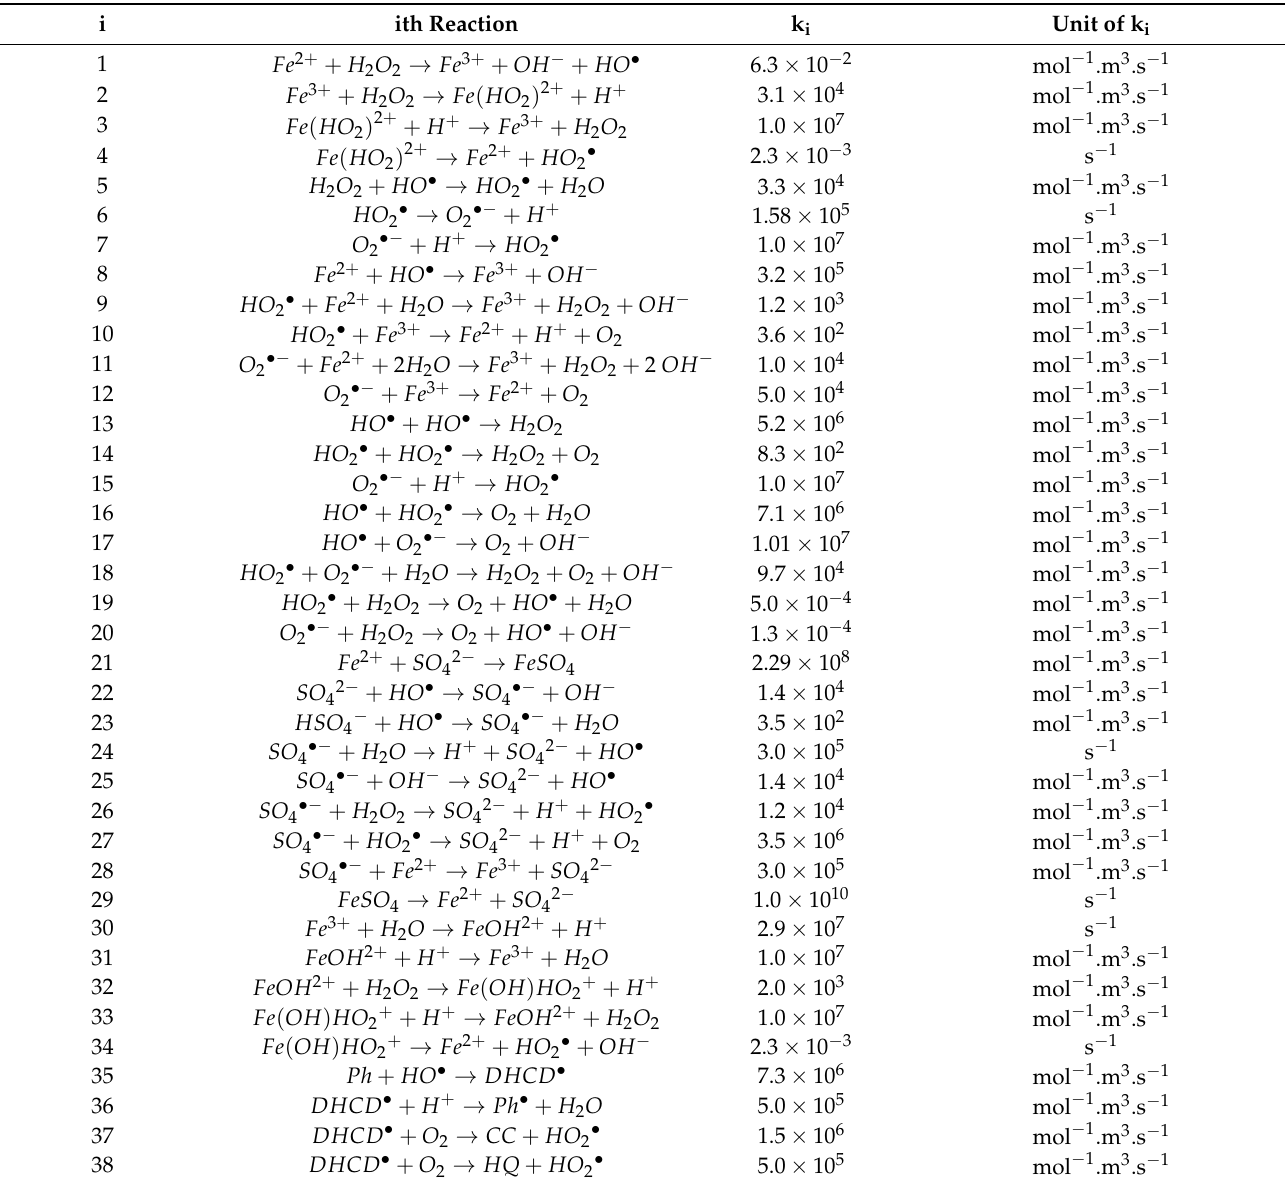
Table 1. Chemical scheme of the possible reactions occurring in the electrolyte by the Fenton-based processes in the presence of phenol; k i is the absolute reaction constant of the i th reaction. Adapted from